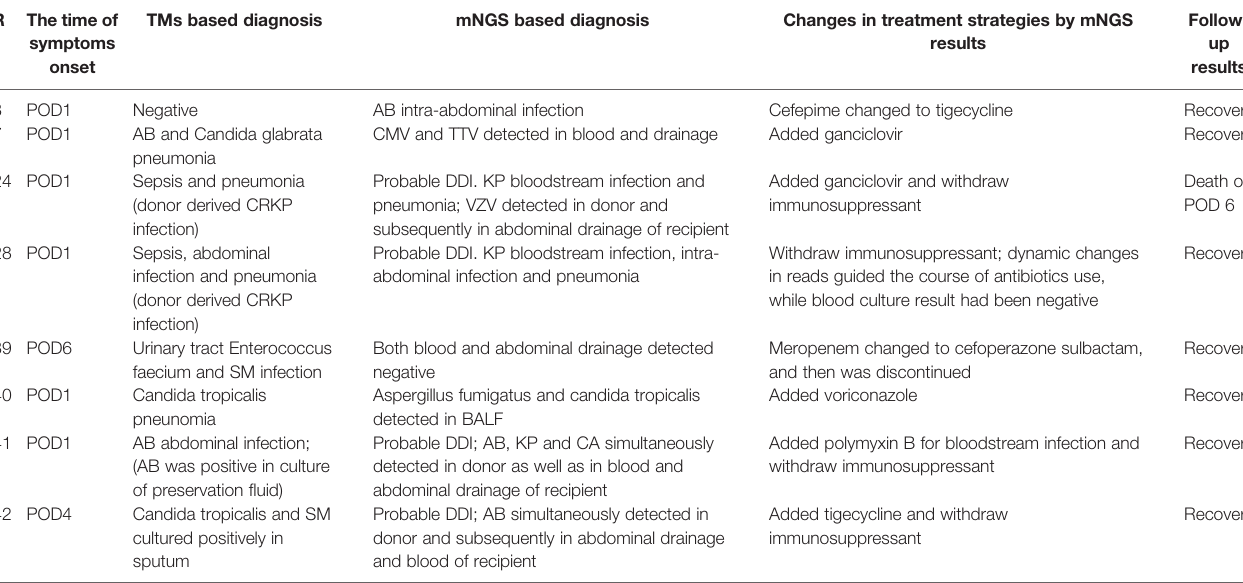
TABLE 5 | The precise treatment of perioperative infection guided by mNGS infailure cases of TMs in LT. R The time of symptoms